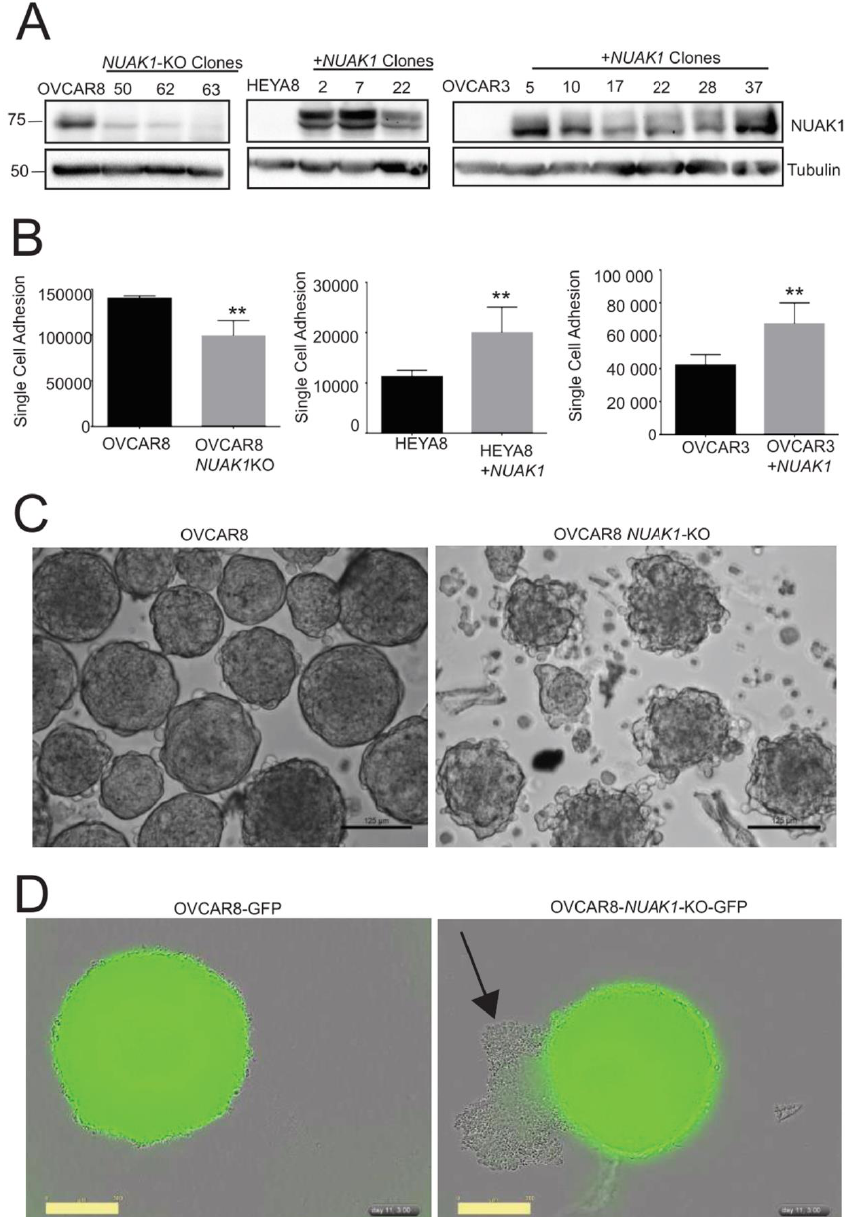
Figure 3. NUAK1 regulates EOC cell adhesion and spheroid integrity. ( A ) Immunoblot analysis of OVCAR8 − NUAK1 KO cells, and HEYA8 + NUAK1 and OVCAR3 + NUAK1 overexpressing cells and matched parental cell lines. Tubulin was used as a loading control. Whole blot images can be found in Figures S32–S37. ( B ) Single cell adhesion was quantified by Trypan Blue Exclusion cell counting for OVCAR8 − NUAK1 KO, HEYA8 + NUAK1, and OVCAR3 + NUAK1 cells and parental cell line controls. Data are presented as absolute cell counts from pooled data among multiple clones. Statistical analysis was performed using two-tailed Student’s t -test (** p < 0.01; n = 3). ( C ) Images of OVCAR8 and OVCAR8- NUAK1 KO spheroids cultured for 11 days in ULA dishes with methylcellulose. Representative images of three independent experiments are displayed. Scale bars represent 125 µ m. ( D ) Images of 11-day OVCAR8 and OVCAR8- NUAK1 KO spheroids stably-transduced with lentivirus expressing NucLight GFP. Phase contrast and green fluorescence images were captured in real-time while using the IncuCyte Zoom imaging system. Arrow indicates cells detached from spheroid and loss of green fluorescence is evident. Representative images of three independent experiments are displayed. Scale bars represent 300 µ